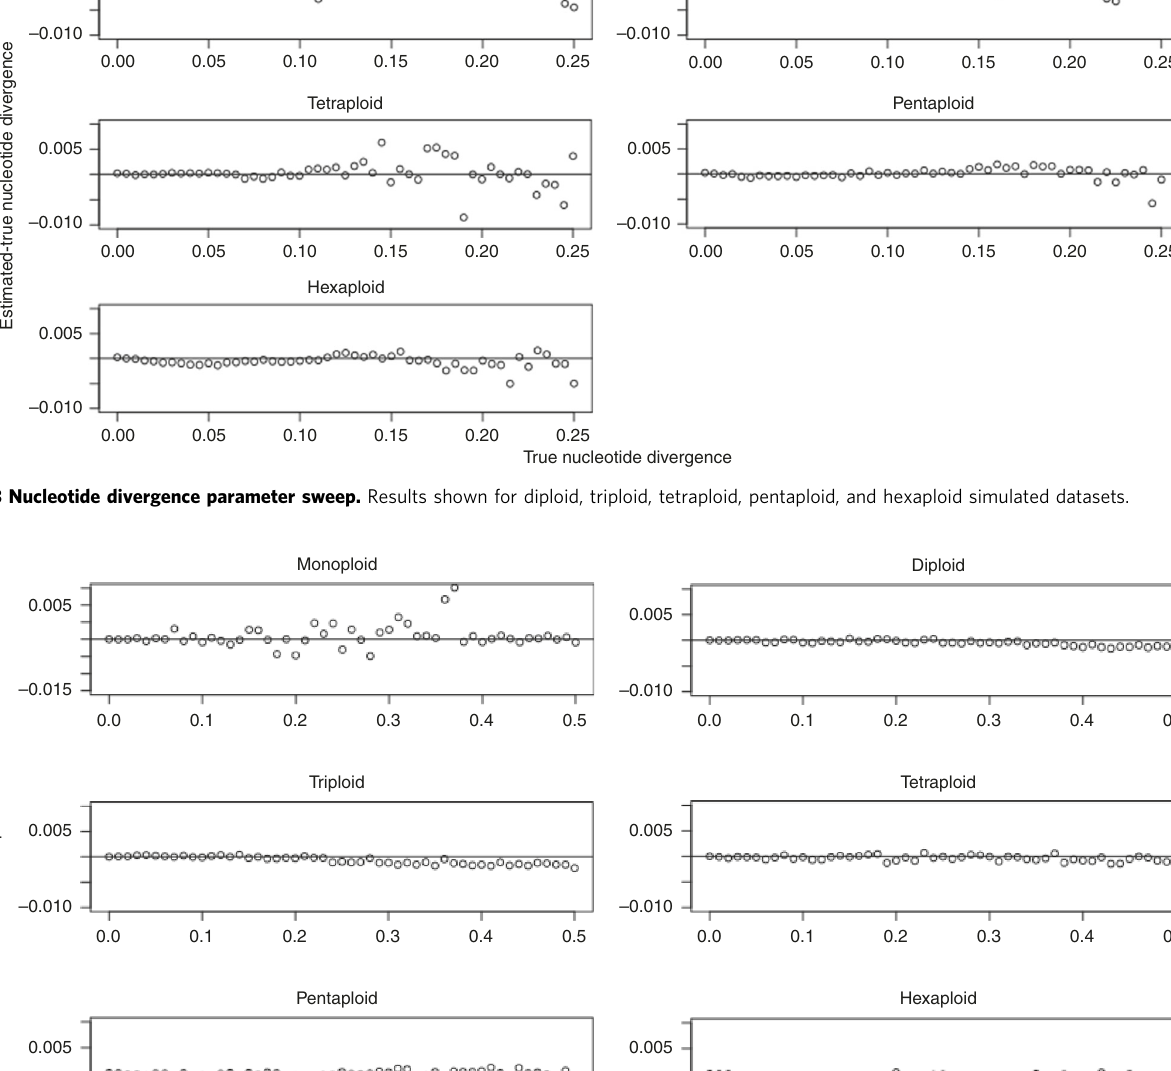
Fig. 4 Repetitiveness parameter sweep. Results shown for monoploid, diploid, triploid, tetraploid, pentaploid, and hexaploid simulated